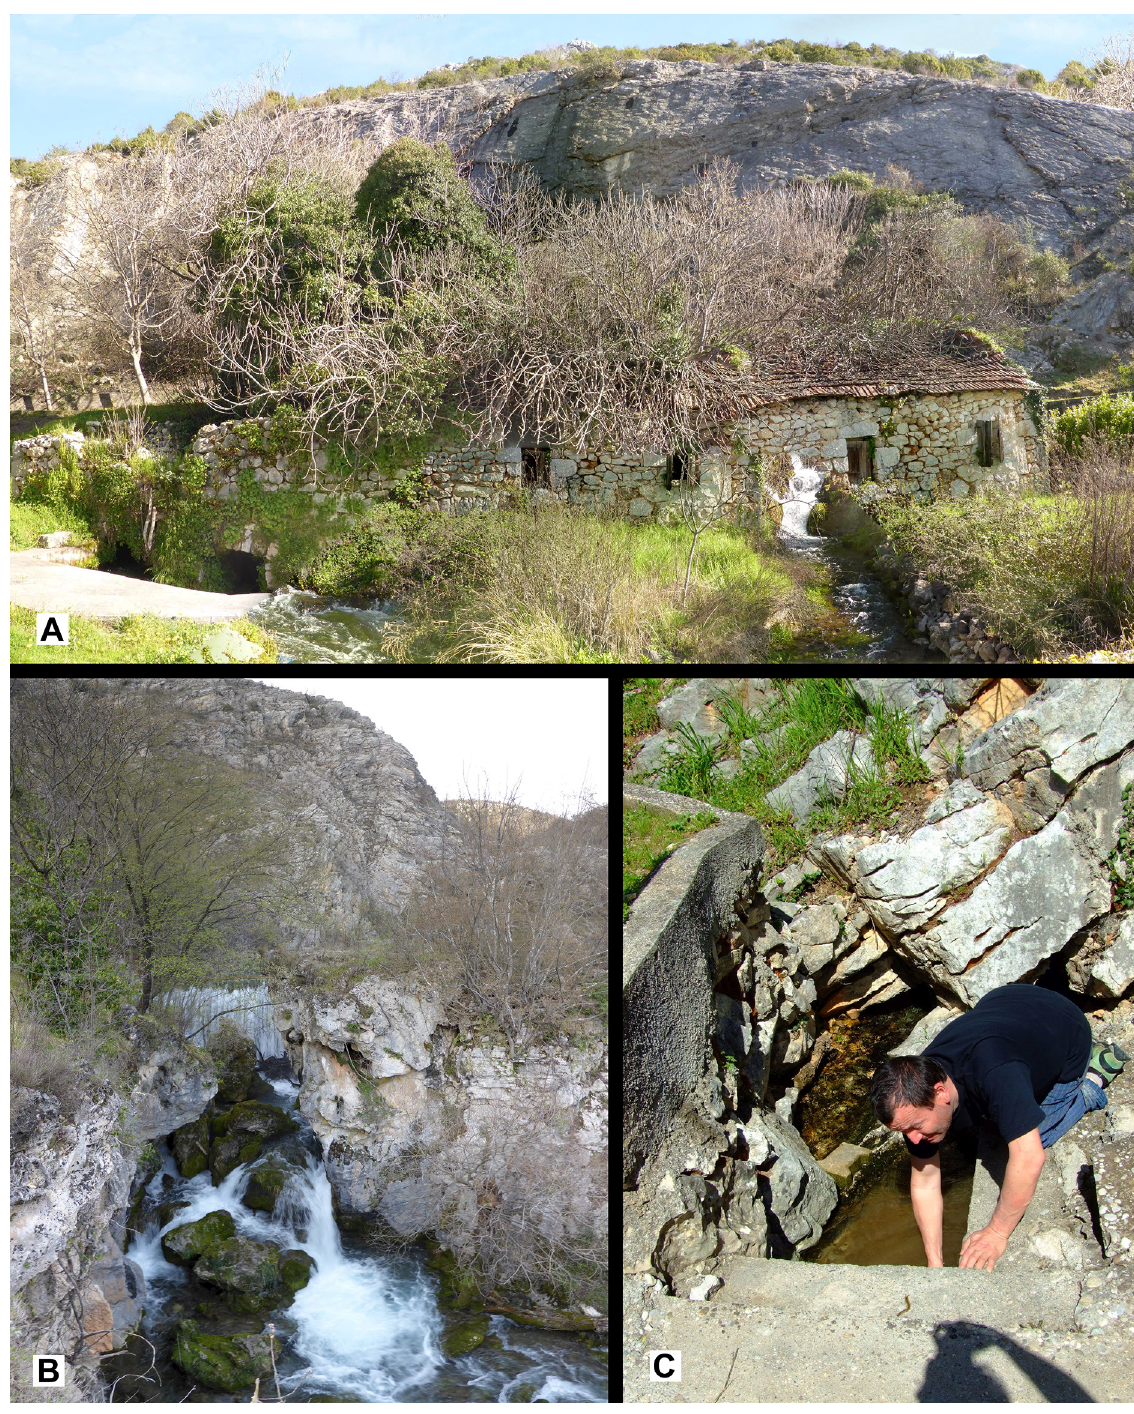
Fig. 4. Photos of studied localities in Hercegovina. A . Studenci, Vrilo Guljevina (LT of Plagigeyeria jakabi sp. nov.). B . Široki Brijeg, Bijelo Vrelo – Lištica 2 (LT of P. listicaensis sp. nov.) C . Donji Prolog, spring Mali Prokop ( P. olsavskyi sp. nov.). Photos: Jozef Grego, Dorottya Angyal and Mário